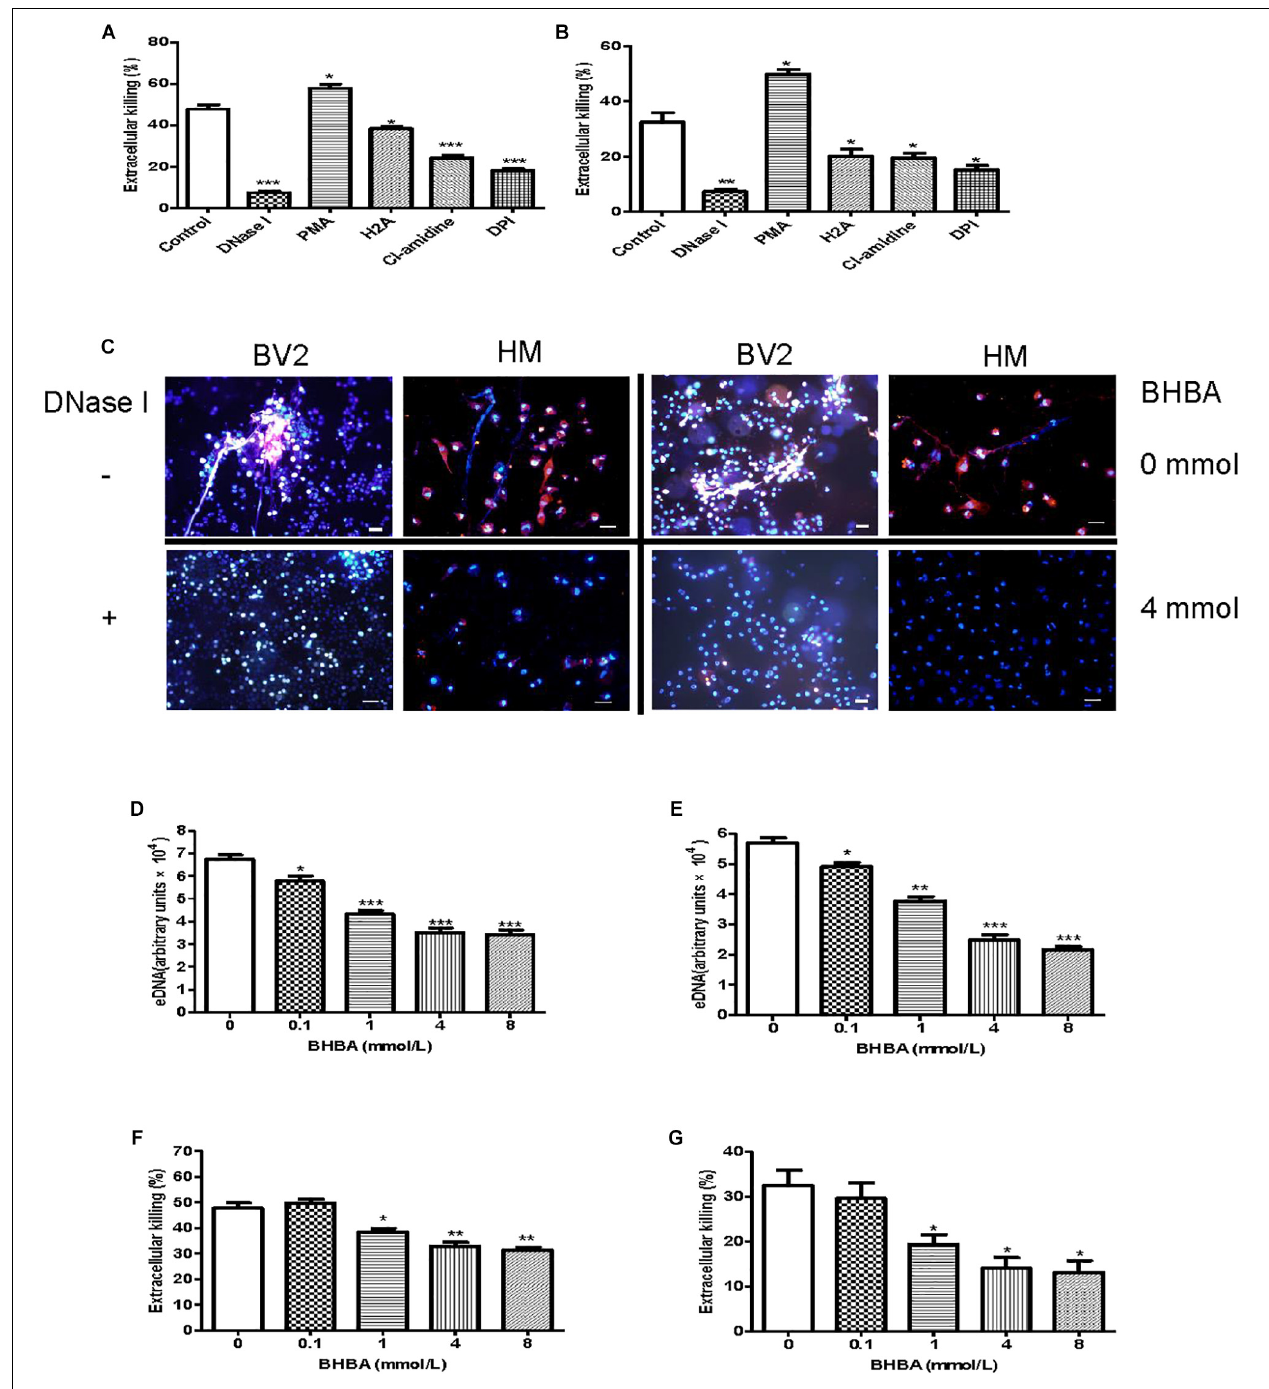
FIGURE 5 | Listeria killing by MiETs in vitro . BV2 cells and human microglia were seeded into 24-well flat bottom plates (2 × 10 5 ) and then pre-treated with DNase I (40 U/ml), H2A (1 µ g/ml) or Cl-amidine (100 µ M) for 1 h. The cells were infected with Listeria (MOI = 50:1) or Listeria and PMA (2 µ M) for 2 h after treatment with 10 µ g/ml cytochalasin D for 20 min. Supernatants and cell lysates of BV2 cells (A) or human microglia (B) were collected for CFU counting and the calculation of the extracellular killing rate. Pictures showed Listeria-infected BV2 cells and human microglia with or without DNase I (40 U/ml) or BHBA treatment (4 mM) (C) . The two cell lines were pre-treated with a series of concentrations of BHBA ranging from 0.1 to 8 mM for 20 min and then infected with Listeria. A plate reader was used to quantitate eDNA contents in BV2 cells (D) and human microglia (E) . The extracellular killing rate was calculated similar to the method described for BV2 cells (F) and human microglia (G) . ∗ p < 0.05, ∗∗ p < 0.01, ∗∗∗ p < 0.001, compared with the control cells. The data are representative of triplicate experiments and presented as the mean value ± the SEM. eDNA was stained with Hoechst 33342 and Sytox orange. Scale bars = 50 µ m.